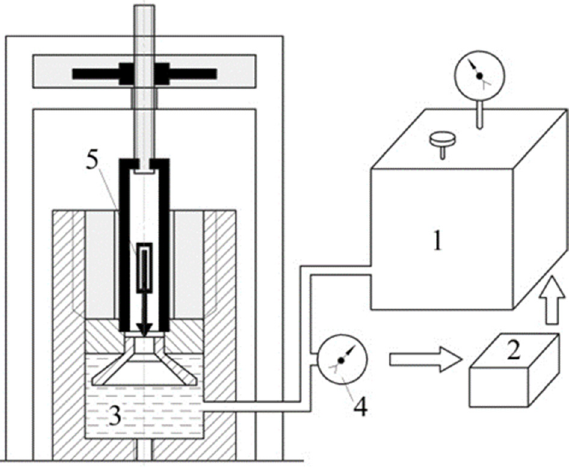
Figure 6. Experimental complex for porthole testing: 1—pumping station, 2—control unit, 3—high- pressure chamber, 4—electric-contact manometer, 5—electric displacement sensors.